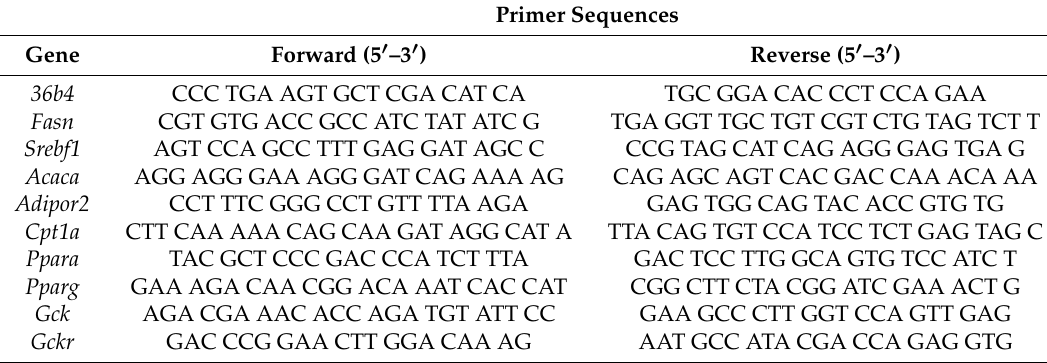
Table 2. Primer sequences used for RT-PCR gene expression